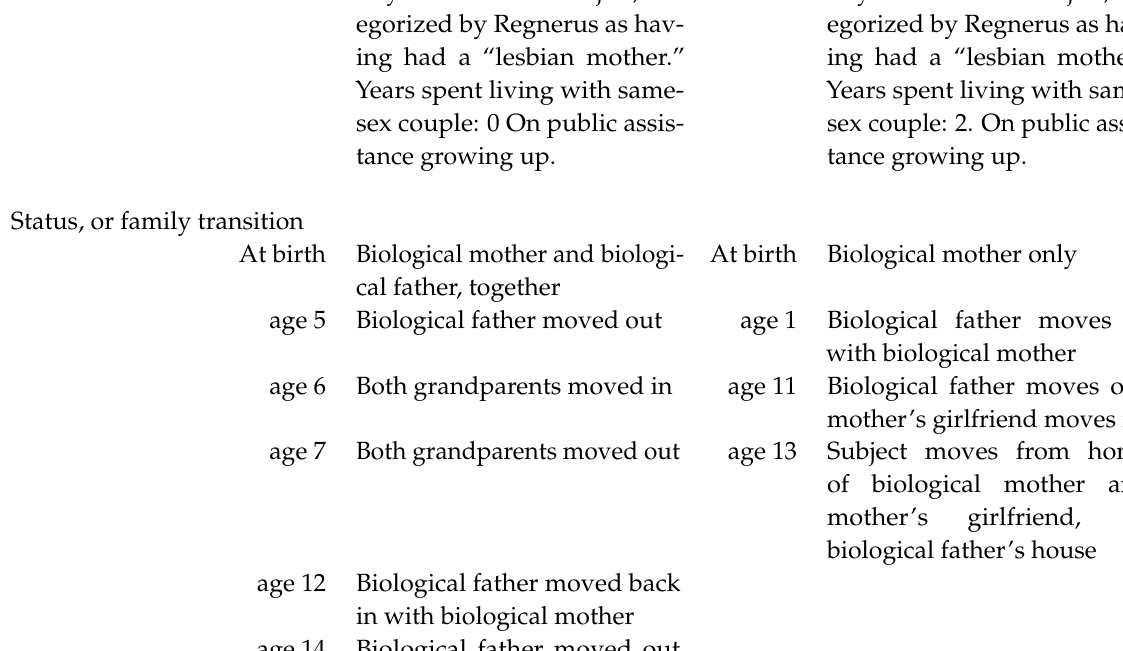
Table 2: Two Typical Life Course Profiles of Women of “Lesbian Mothers” from NFSS